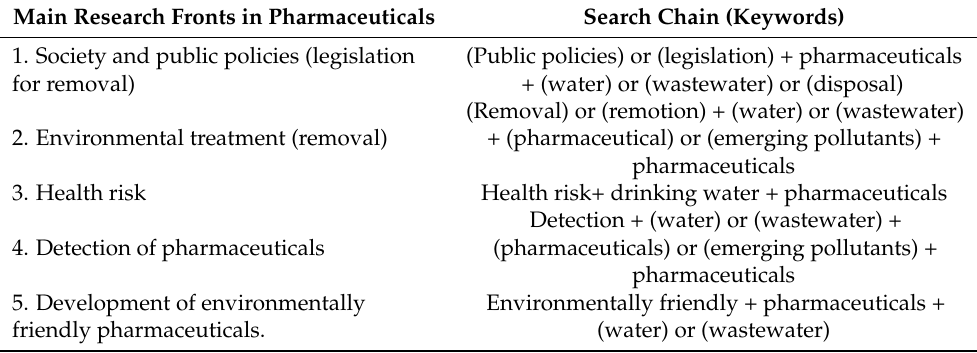
Table 5. Pharmaceutical research fronts in under study in